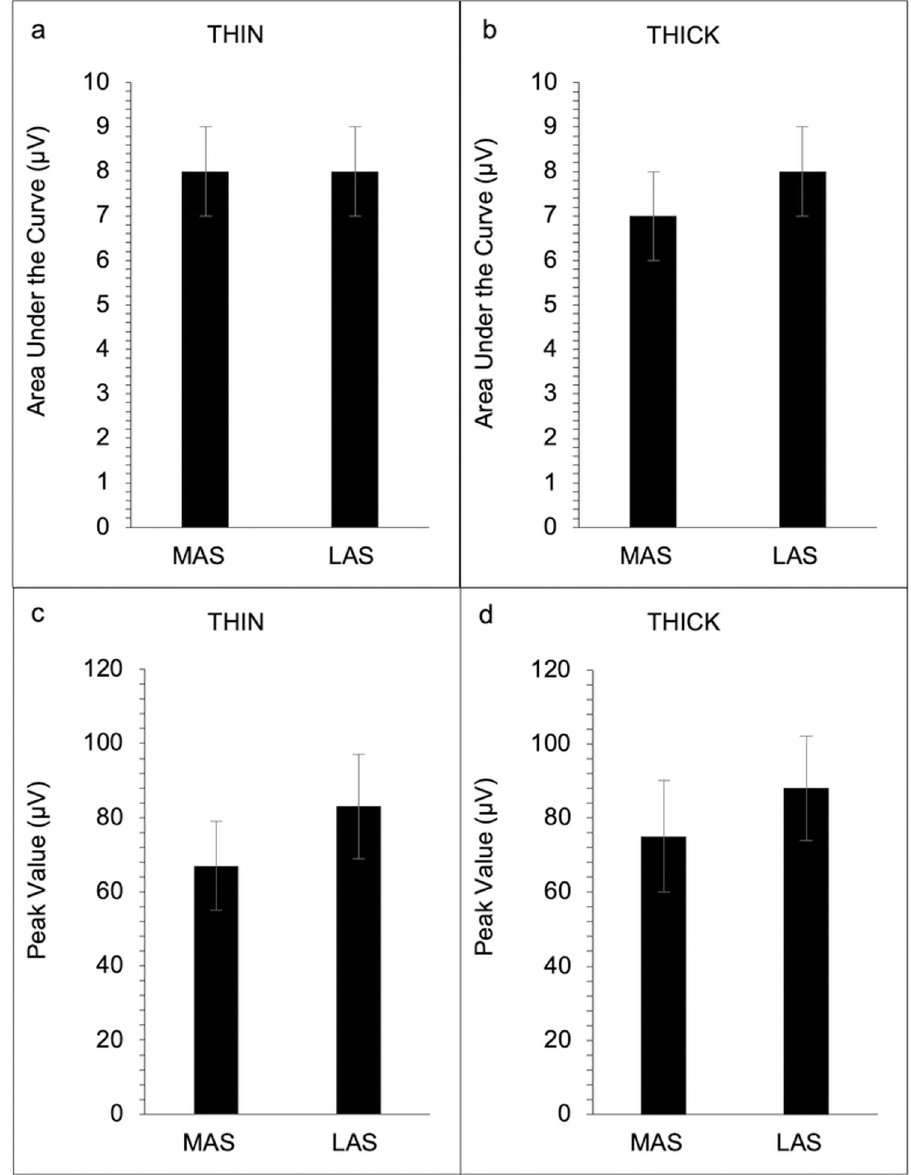
Fig 2. EMG measures for laryngeal muscles groups for Most Affected Side (MAS) and Least Affected Side (LAS) across both swallow conditions (N = 23). Area under the curve for the laryngeal muscle group for the thin swallow condition (a), and area under the curve for the laryngeal group for the thick swallow condition (b). Peak amplitude for the laryngeal muscle group during the thin swallow condition (c), and peak amplitude for the laryngeal muscle group during the thick swallow condition (d). Error bars reflect standard